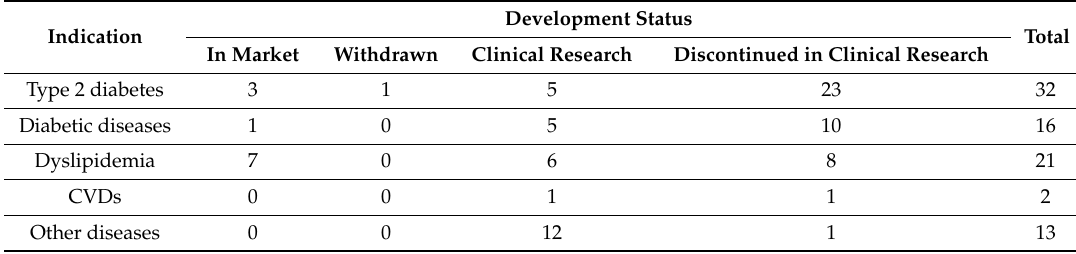
Table 1. Medications of PPAR synthetic ligands in currently clinical applications or